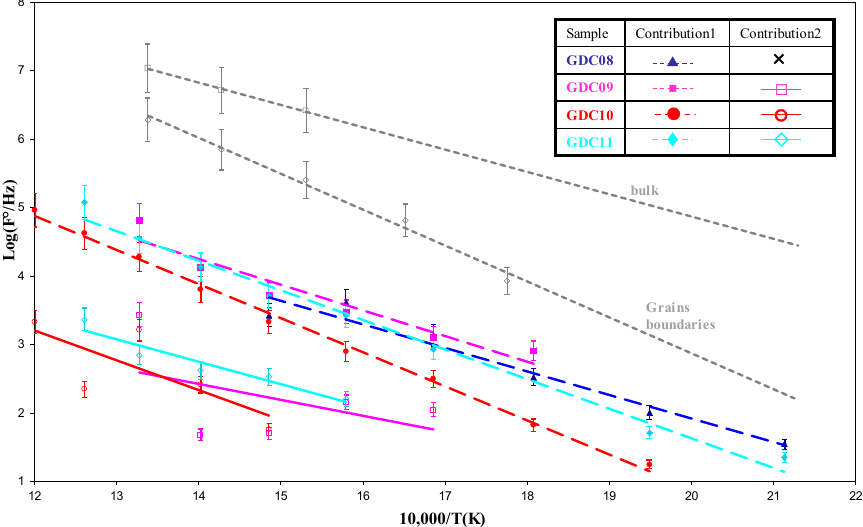
Figure 6. Arrhenius plots of the relaxation frequencies as a function of the temperature compared to those of a bulk sintered GDC sample.